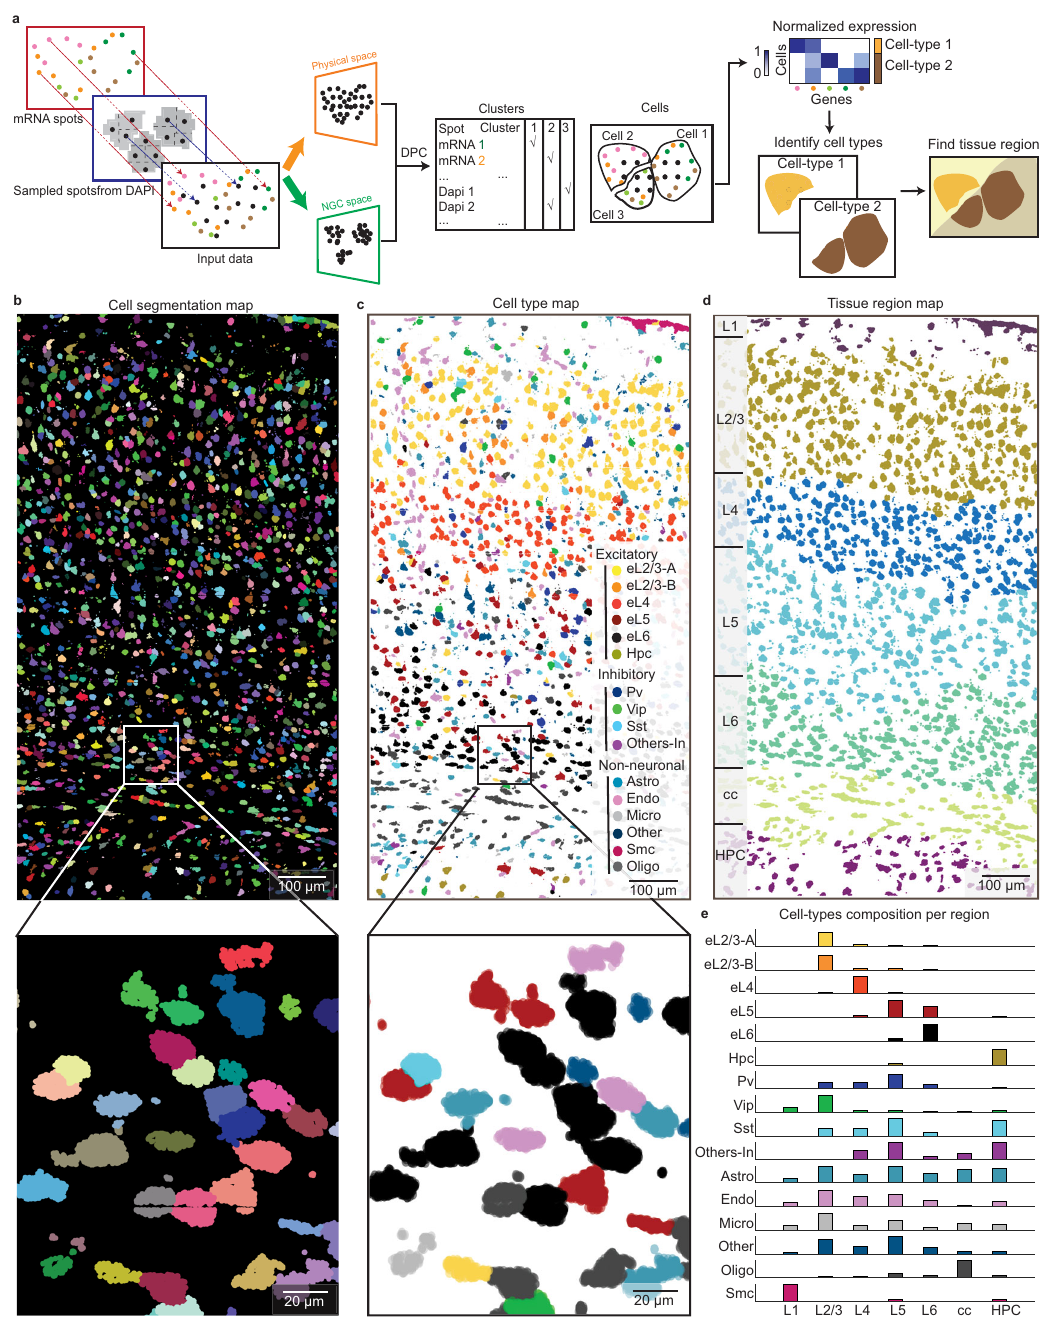
Fig. 2 ClusterMap generates cell-type and tissue-region maps in mouse primary cortex (V1). a Work fl ow of ClusterMap method that integrates DAPI signals for spatial clustering. b – d ClusterMap generates cell (segmentation) map ( b ), cell-type map ( c ), and tissue region map ( d ) of the STARmap mouse V1 1020-gene dataset 6 , which includes 1599 identi fi ed cells. b mRNA molecules are color-coded by their cell attributes. c The cell type names and colorings are from ref. 6 . Bottom panels in b , c show the zoomed-in views from the rectangular highlighted regions in upper panels. d The tissue regions are segmented and cells in the same layer are shown in the same color. From top to bottom, the tissue region map shows: L1 to L6, the six neocortical layers; cc, corpus callosum; HPC, hippocampus. e Bar plots of composition of 16 cell types across 7 layers. Values are normalized in each row. The colors correspond to the cell type legend in c structural and functional organization of complex organs. In this hierarchical clustering 28 separated cells into three categories with regard, exploring ClusterMap ’ s ability to analyze 3D in situ distinct molecular signatures (Fig. 6a – c): CD44 for mesenchymal transcriptomics is particularly desired. We applied ClusterMap to stem cells (MSCs), Nanog for induced pluripotent stem cells (iPSCs) and four genes ( TNNI1 , MYH7 , MYL7 , ATP2A2 ) for dataset 27 and STARmap mouse V1 28-gene dataset 6 (Supple- cardiomyocytes (Supplementary Fig. 10a – c). The 100- μ m-thick sample of mouse V1 includes all six cortical layers and the corpus callosum, in which up to 24,000 cells were identi fi ed and 3D protocol described in Fig. 1b. In the 3D cardiac organoid sample,